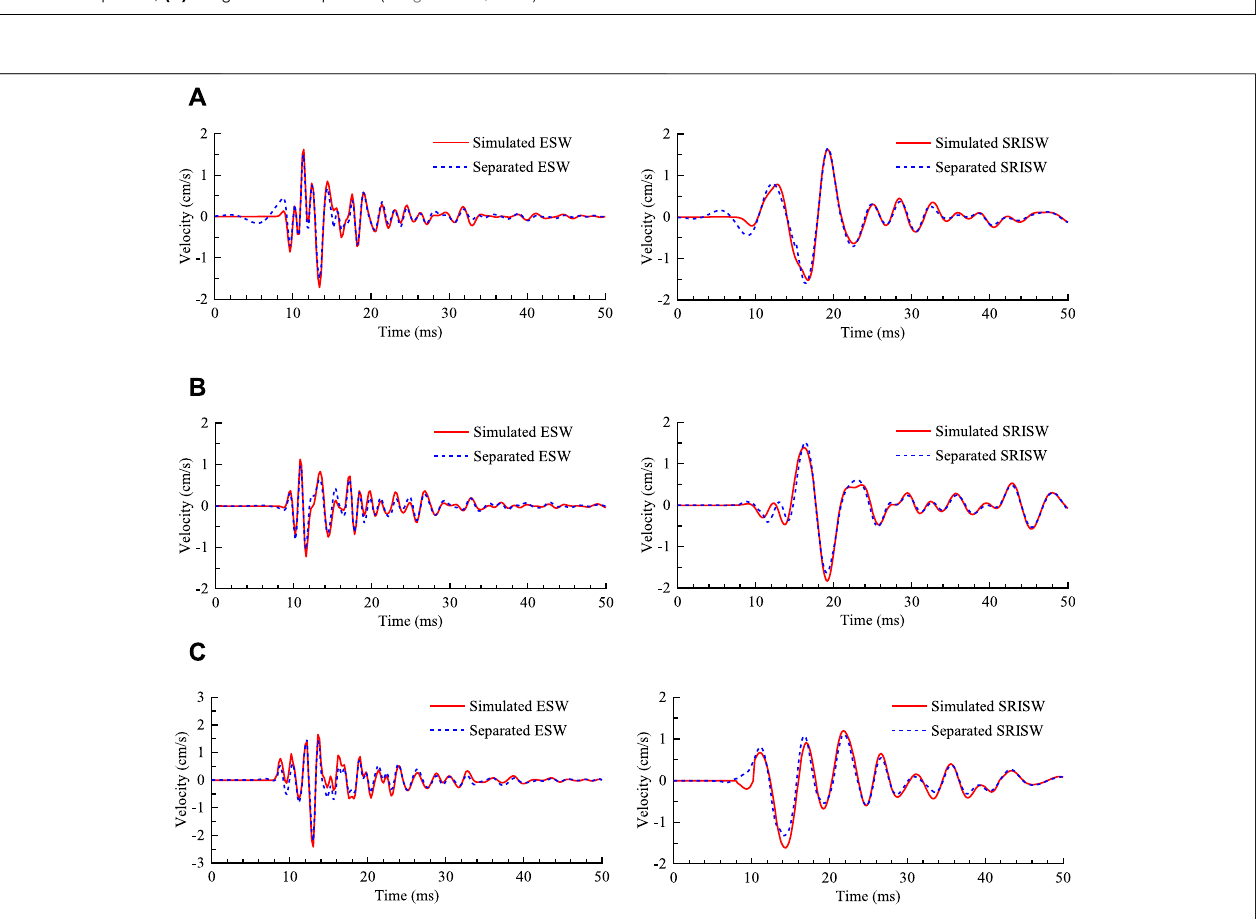
FIGURE 10 | Comparisons between the separated seismic waves based on VMD and the simulated seismic waves. (A) Transverse component, (B) Vertical component, (C) Longitudinal component.